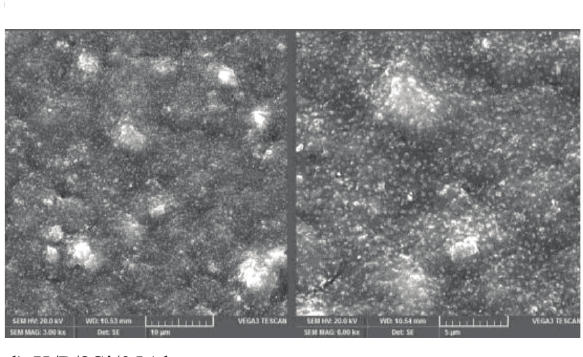
Fig. 2 – Static water contact angles measured over time evo- lution of 6 s